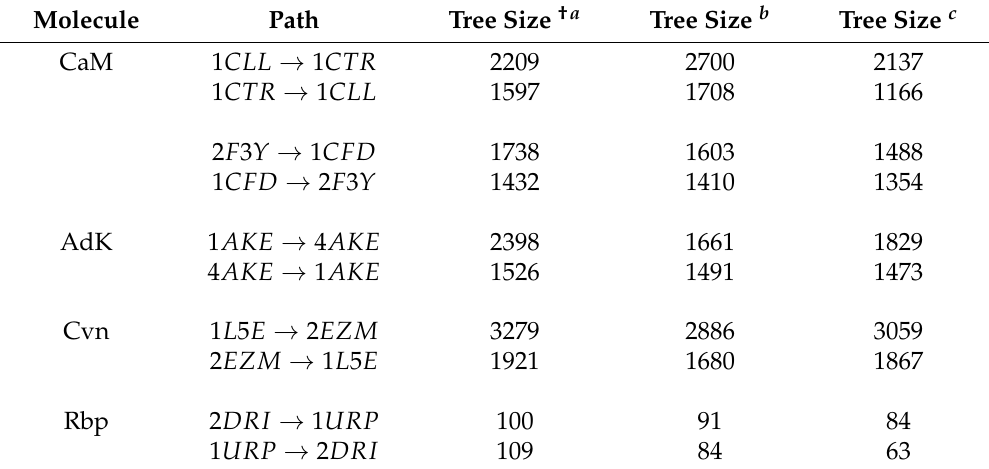
Table 2. Comparison of memory usage, size of the trees